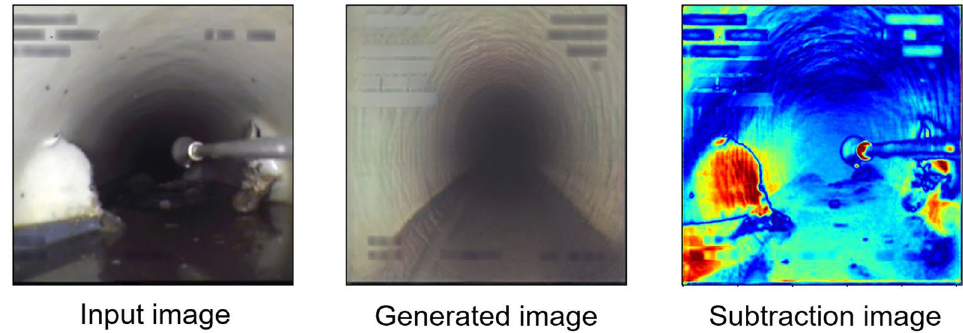
Fig. 21 Experimental results of obstacle anormaly pipe (GAN)